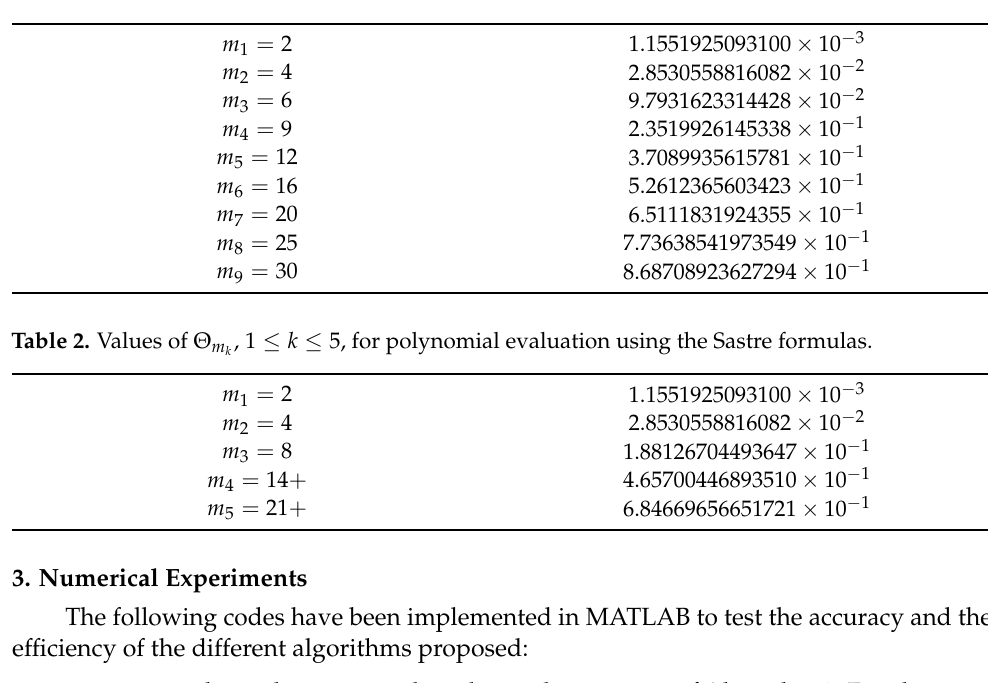
Table 1. Values of Θ m , 1 ≤ k ≤ 9, for polynomial evaluation by means of the Paterson–Stockmeyer k method.